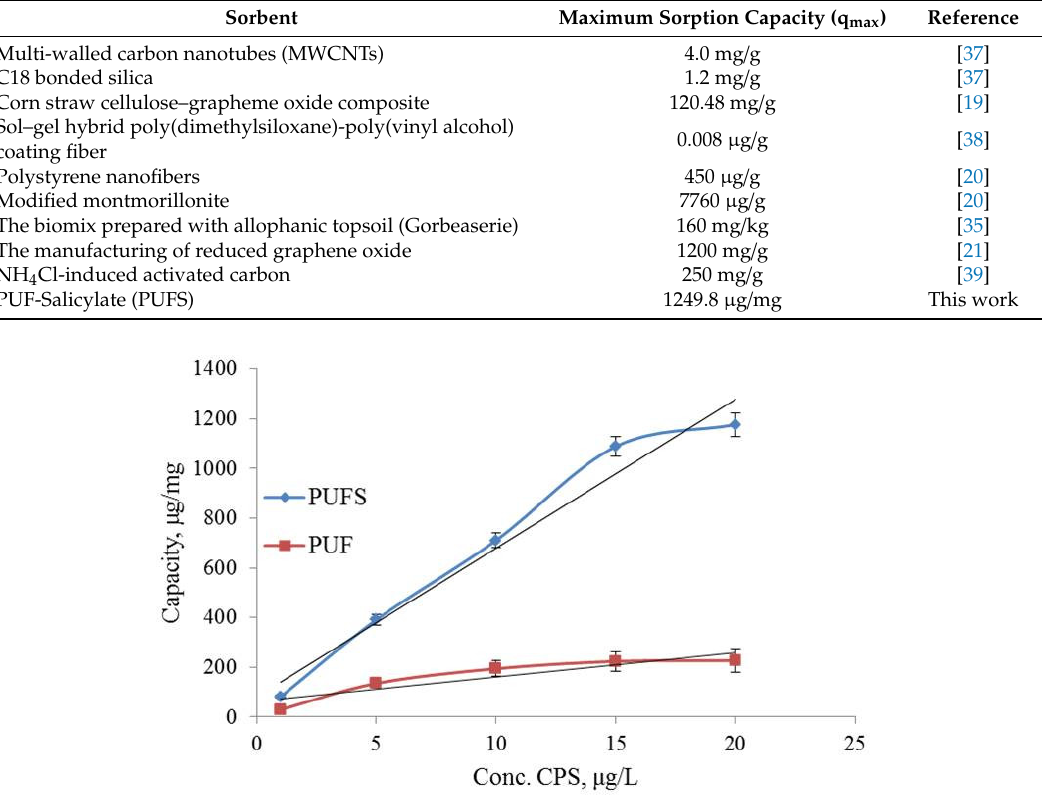
Table 3. Comparison of Maximum Sorption Capacities of Chlorpyrifos Removal.